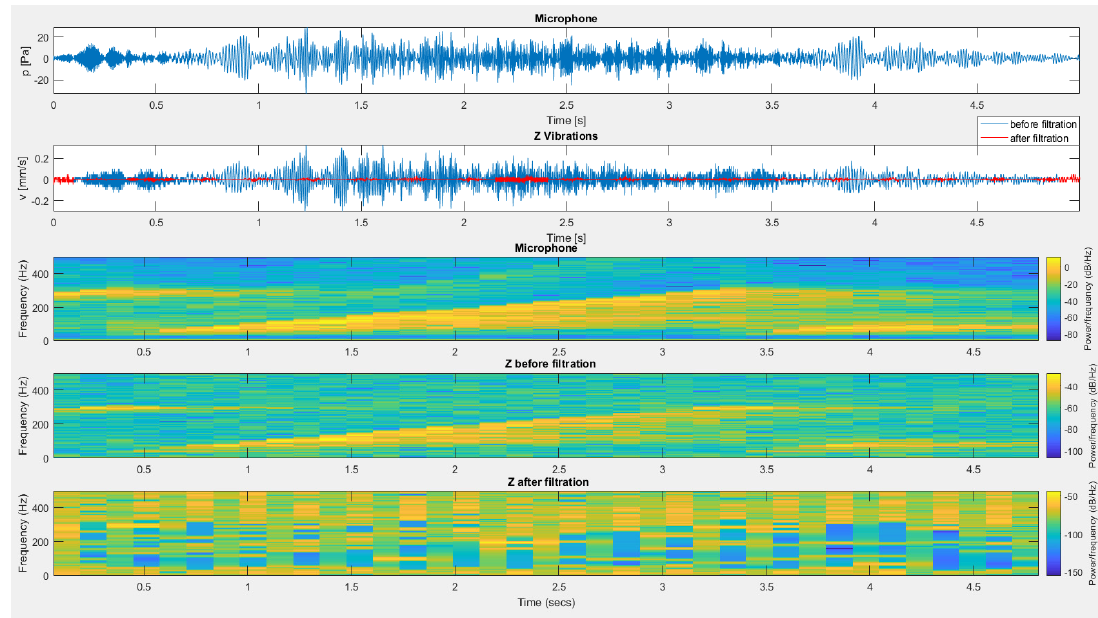
Figure 13. The result of using filtration for the data from the recording shown in Figure 5 (test No. I) for the vertical component of the sensor placed on the mat.